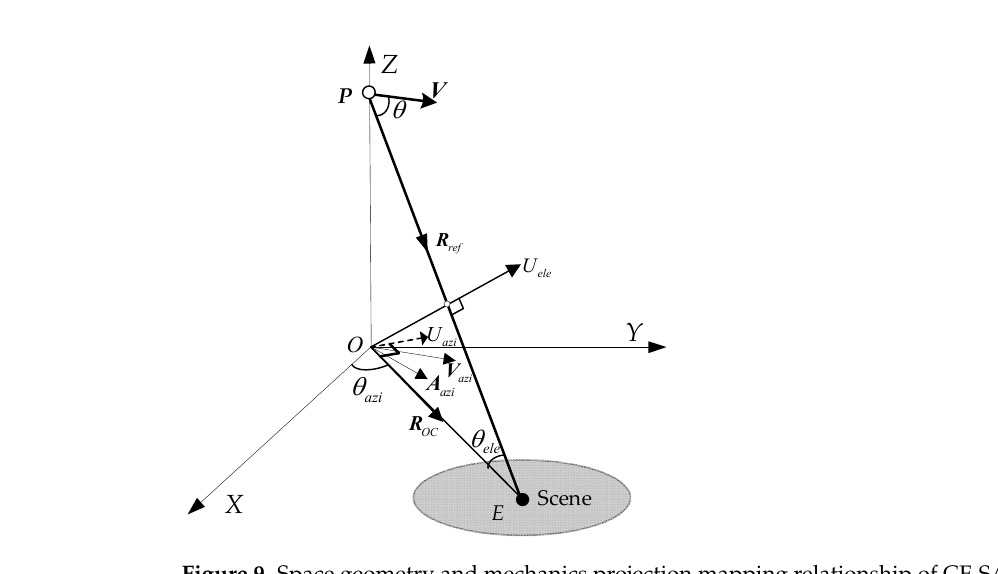
Figure 9. Space geometry and mechanics projection mapping relationship of CF-SAR.